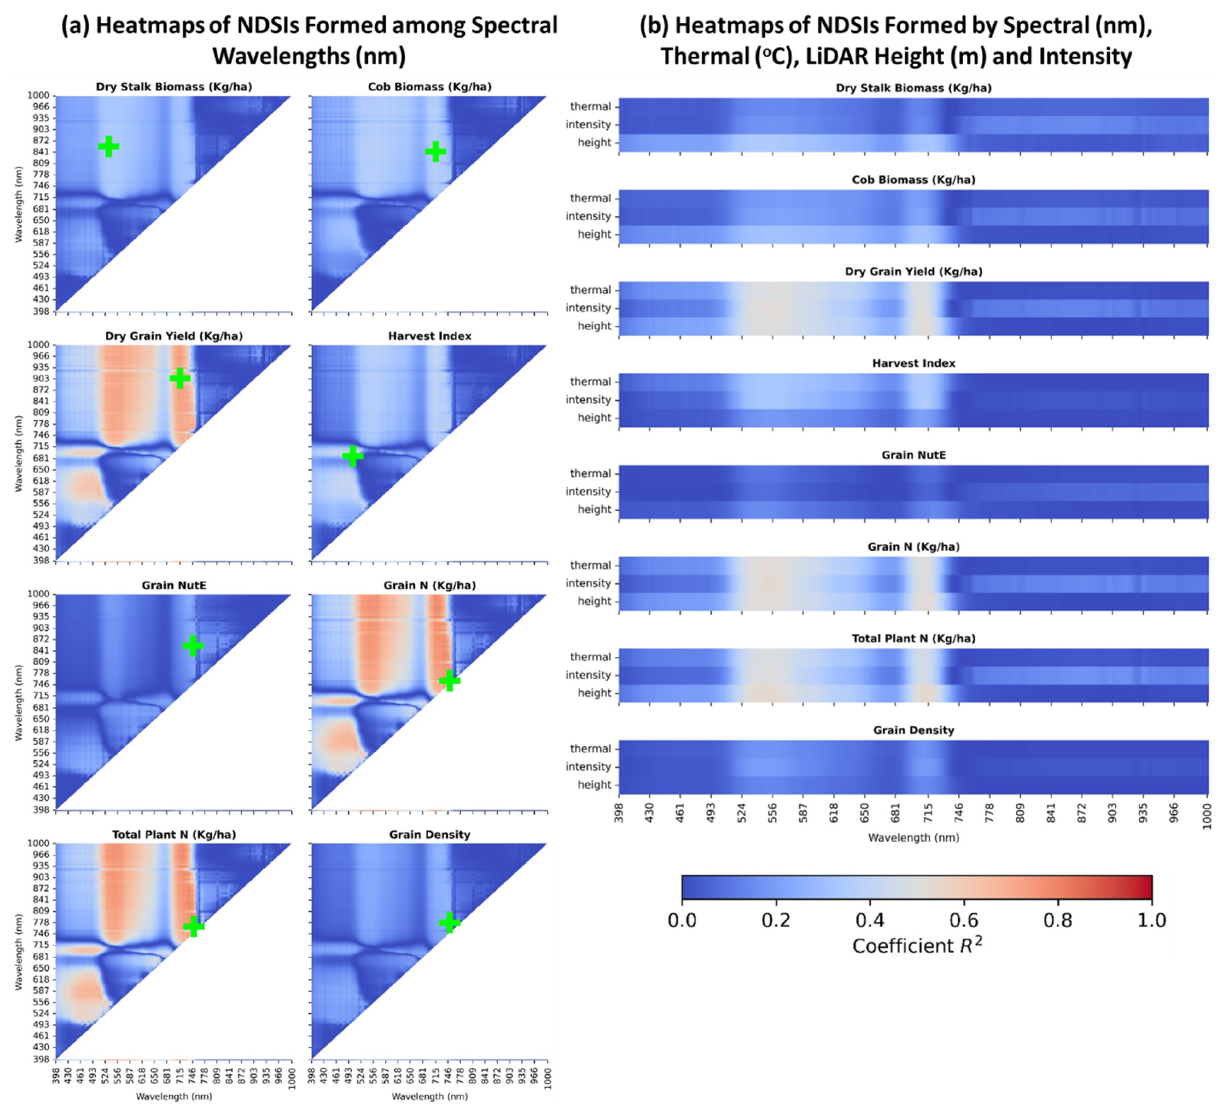
Figure 7. Extended NDSI correlation heatmaps. Each NDSI was established by combining and normalizing two 269 singular spectral bands (398 nm–1000 nm) ( a ), and fused features from spectra, LiDAR canopy height, LiDAR canopy intensity, and canopy thermal data ( b ). The lime-colored cross signs indicated the best R 2 for each maize trait. In detail, Dry Stalk Biomass achieved a maximum R 2 = 0.357 with NDSI [534, 868] . Cob Biomass optimally gained R 2 = 0.384 at NDSI [715, 855] . Dry Grain Yield had the highest R 2 = 0.746 at NDSI [715, 917] . Harvest Index received the highest R 2 = 0.451 at NDSI [504,